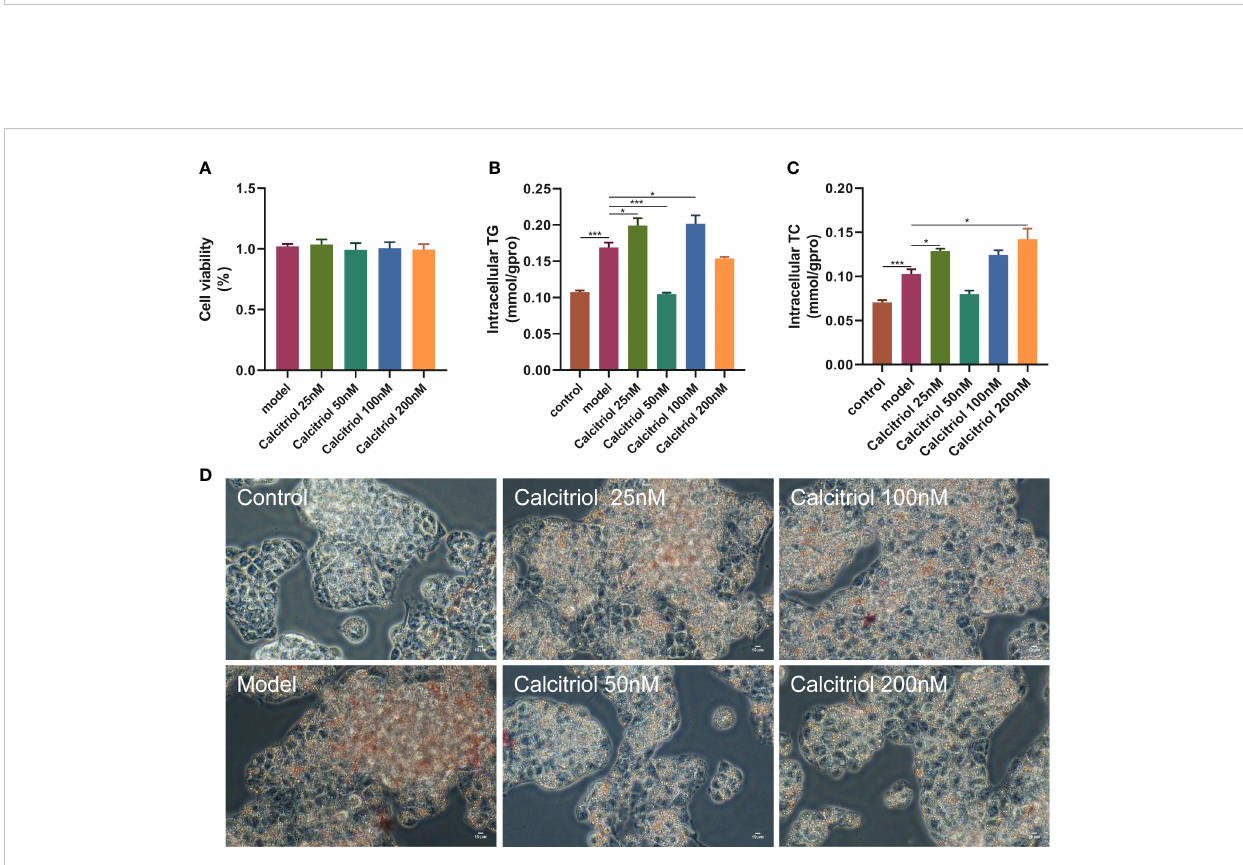
FIGURE 5 Effect of calcitriol on lipid deposition in HepG2 cells. Cytotoxic effects after (A) calcitriol (0-200nM) for 24 h were evaluated by CCK8 assay. (B) Intracellular TG and (C) TC were assayed in HepG2. (D) Intracellular lipid accumulation was detected by Oil red O staining method using an inverted microscope (400× magni fi cation). Data were shown as the mean ± SEM. *P < 0.05, ***P <